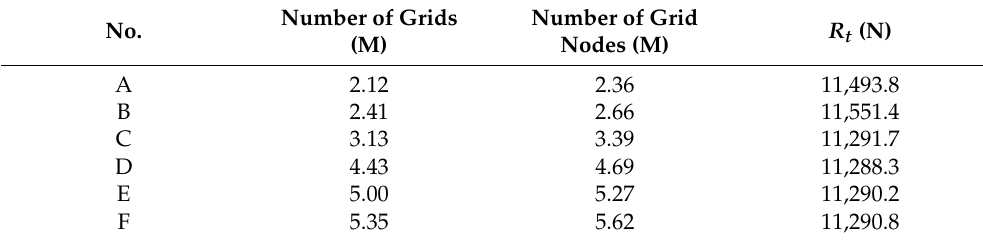
Table 2. Mesh convergence study ( α = 90 ◦ ).